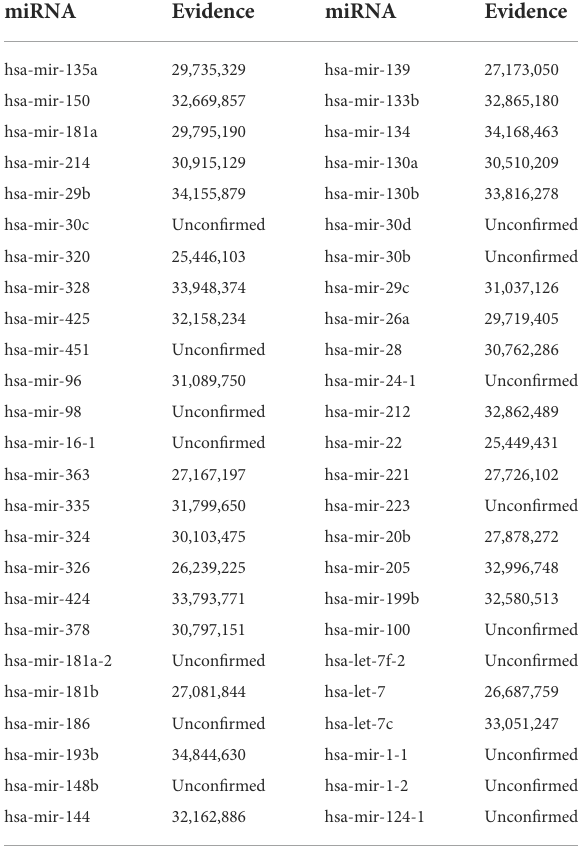
TABLE 5 Validation of the top 50 predicted miRNAs related to 5-FU (DB00544). miRNA Evidence miRNA